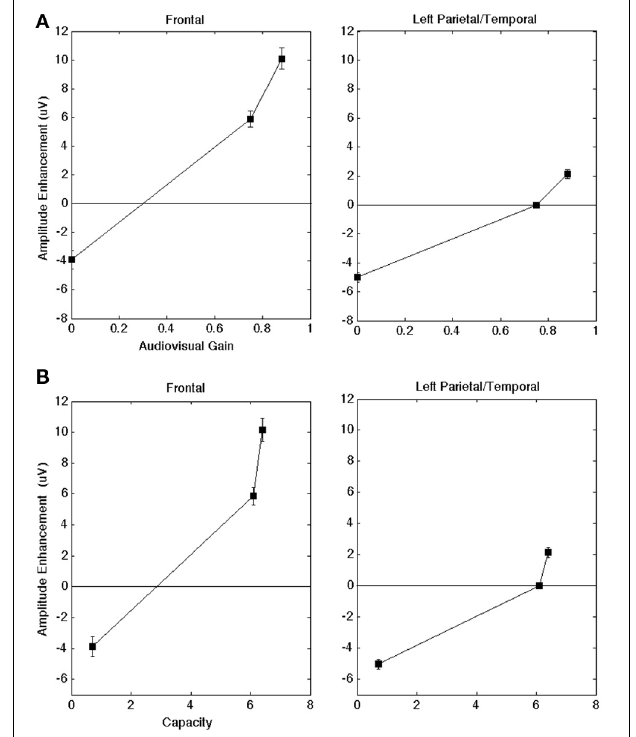
FIGURE 4 | (A) AV gain in amplitude for the peak ERP (AV − A) as a function of audiovisual gain across brain regions of interest. A positive value means that the average AV amplitude was larger than the A. The scores are collapsed across each of the four participants. (B) Audiovisual gain in amplitude as a function of capacity scores (in the clear, − 12dB, and − 18dB S/N ratio conditions, respectively) across brain regions of interest. The scores are collapsed across each of the four participants. Error bars denote one standard error of the mean computed across individual electrodes (across subjects) within a given